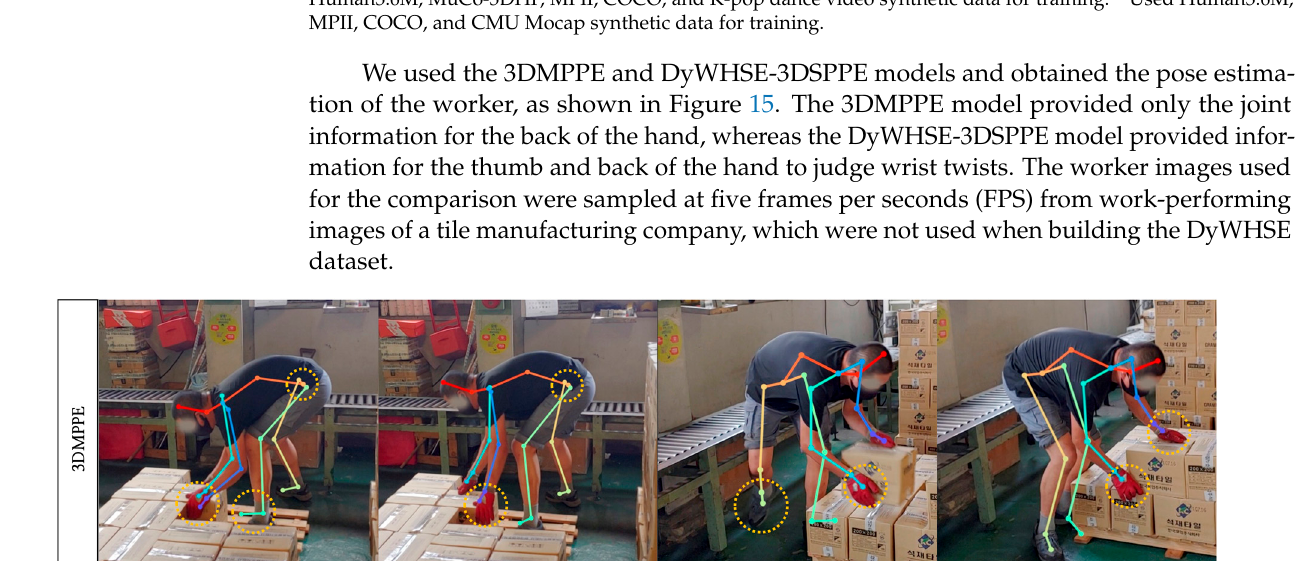
1 Used Human3.6M and MPII synthetic data for training. 2 Used DyWHSE, Human3.6M, and MPII synthetic data for training. 3 Used DyWHSE, Human3.6M, and COCO synthetic data for training. 4 Used DyWHSE, Human3.6M, MuCo-3DHP, MPII, COCO, and K-pop dance video synthetic data for training. 5 Used Human3.6M, MPII, COCO, and CMU Mocap synthetic data for training.